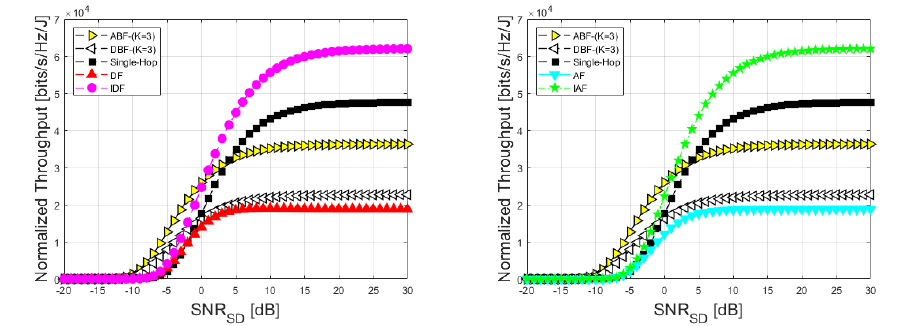
( c ) The comparison with the ABF, the DBF, ( d ) The comparison with the ABF, the DBF, the single-hop, the DF, and the IDF single-hop, the AF, and the the IAF Figure 12. Normalized throughput vs.